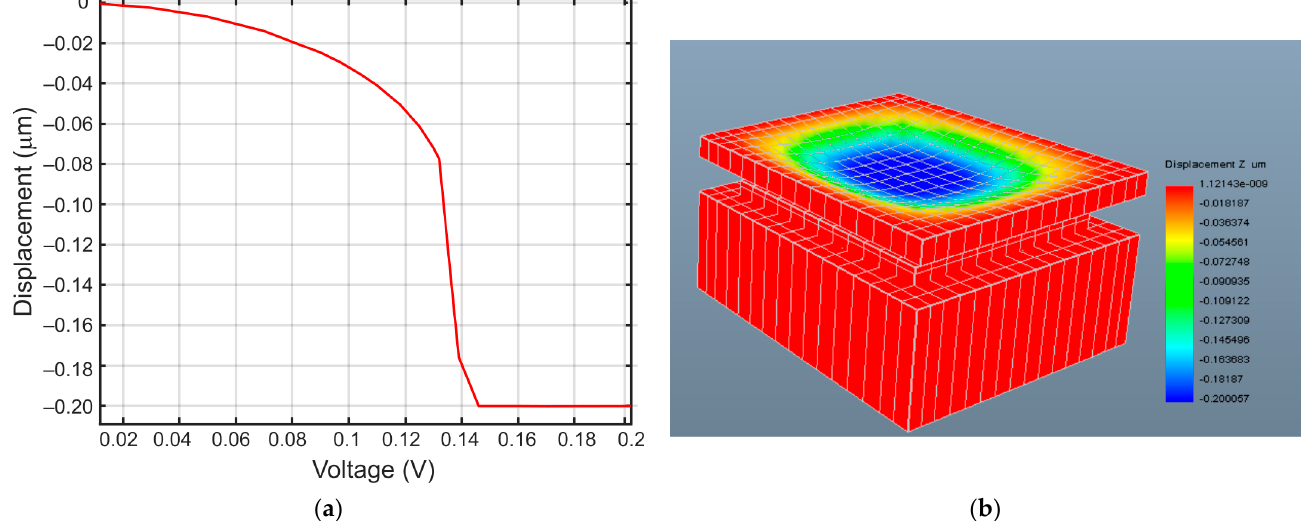
Figure 9. Pull ‐ in voltage simulation of the sensor capacitor in IntelliSuite™. ( a ) IntelliSuite™ 3D electromechanical FEA result showing the displacement of the diaphragm center due to the nonlinear electrostatic force following (4) as a function of bias voltage; ( b ) 3D FEA model of the sensor capacitor geometry in IntelliSuite™ design environment showing the collapsed diaphragm after pull ‐ in.